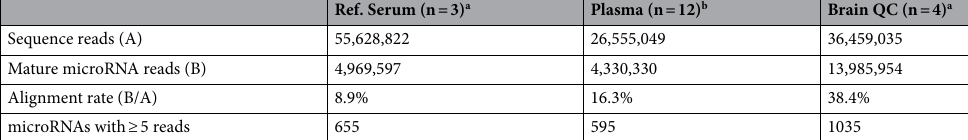
Table 3. Summary statistics from miRNA-Seq. a Average of inter-run replicates (number of replicates in parentheses). b Average of plasma libraries from 12